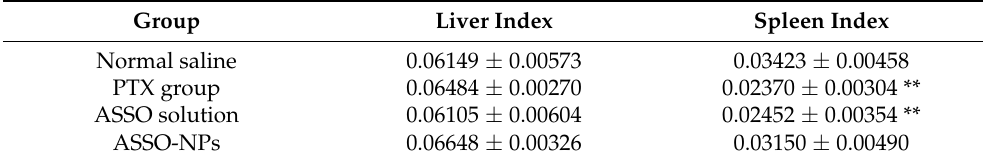
Table 3. The liver index and spleen index of all groups (mean ± SD, n = 6). Group Liver